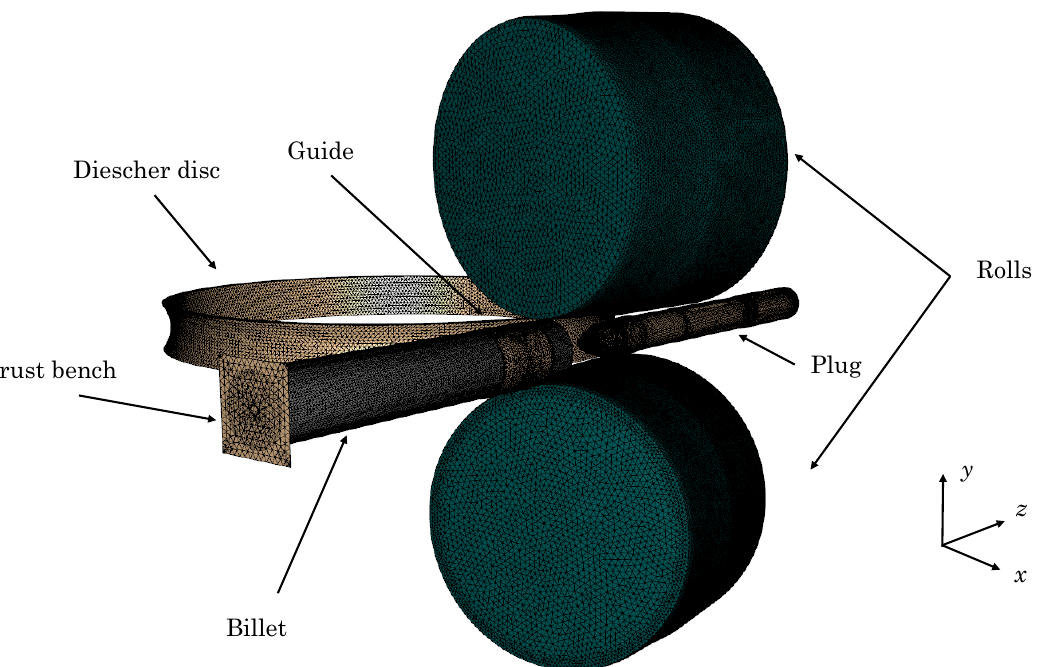
Figure 1. Meshing and layout of the rotary tube piercing mill (one of the lateral Diescher discs is not